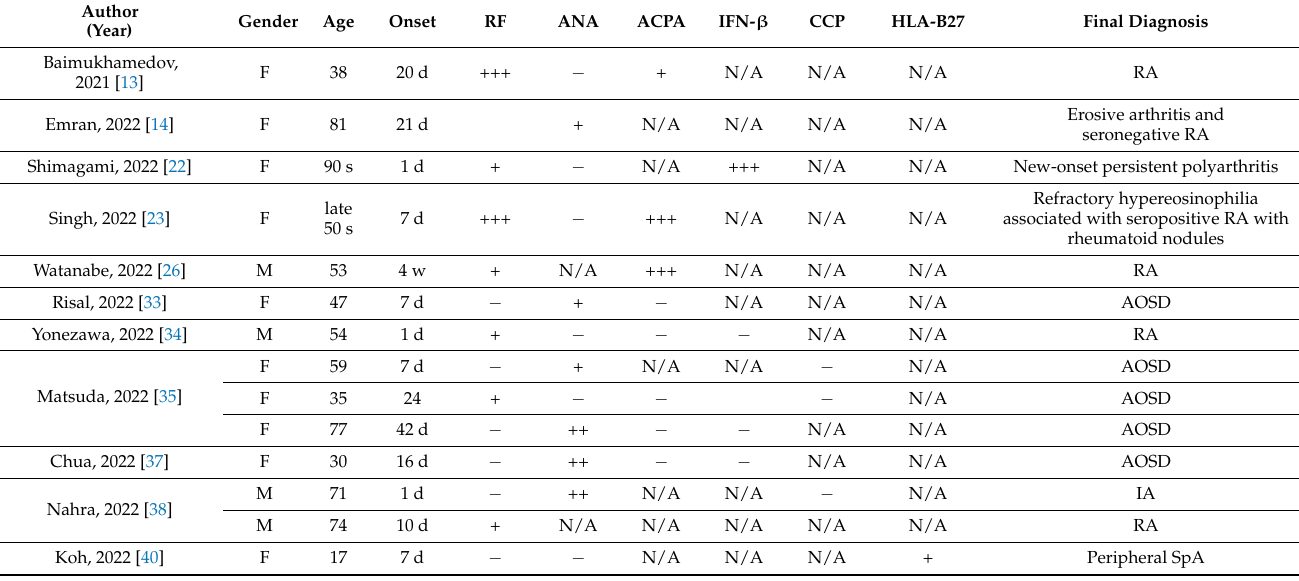
Table 3. Cases with abnormal autoimmune